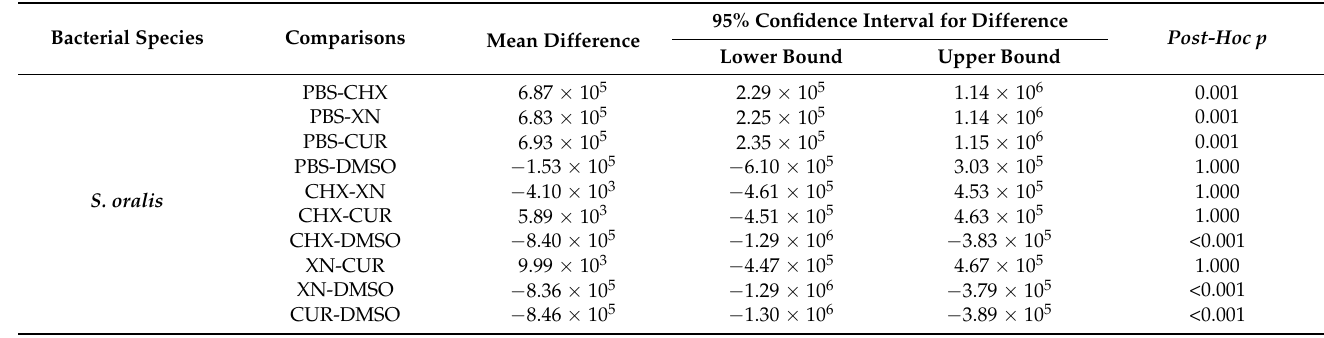
Table 2. Comparisons between experimental treatments and the controls used as observed in the mean number of viable bacteria counts (colony forming units per mL (CFUs) mL − 1 , determined by qPCR) evaluated in an in vitro multi-species dynamic biofilm model. Differences are considered statistically significant at p <